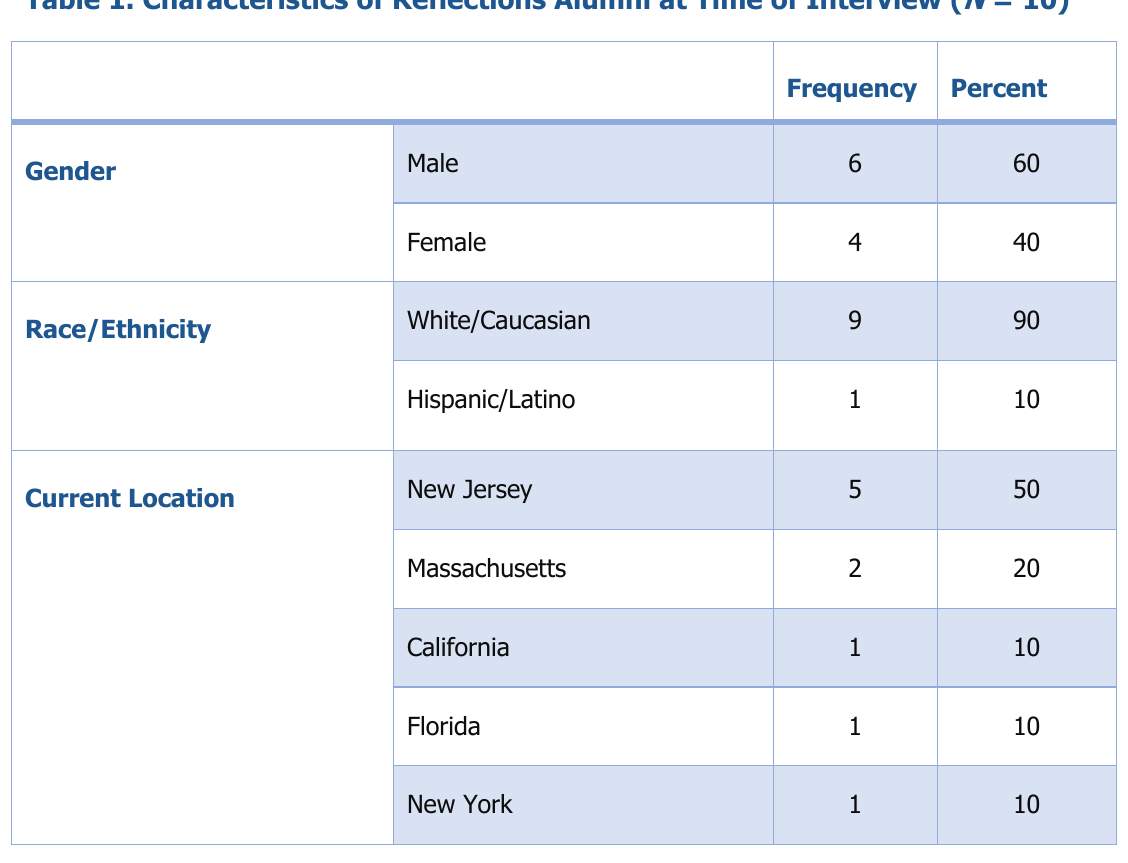
Table 1. Characteristics of Reflections Alumni at Time of Interview (N =